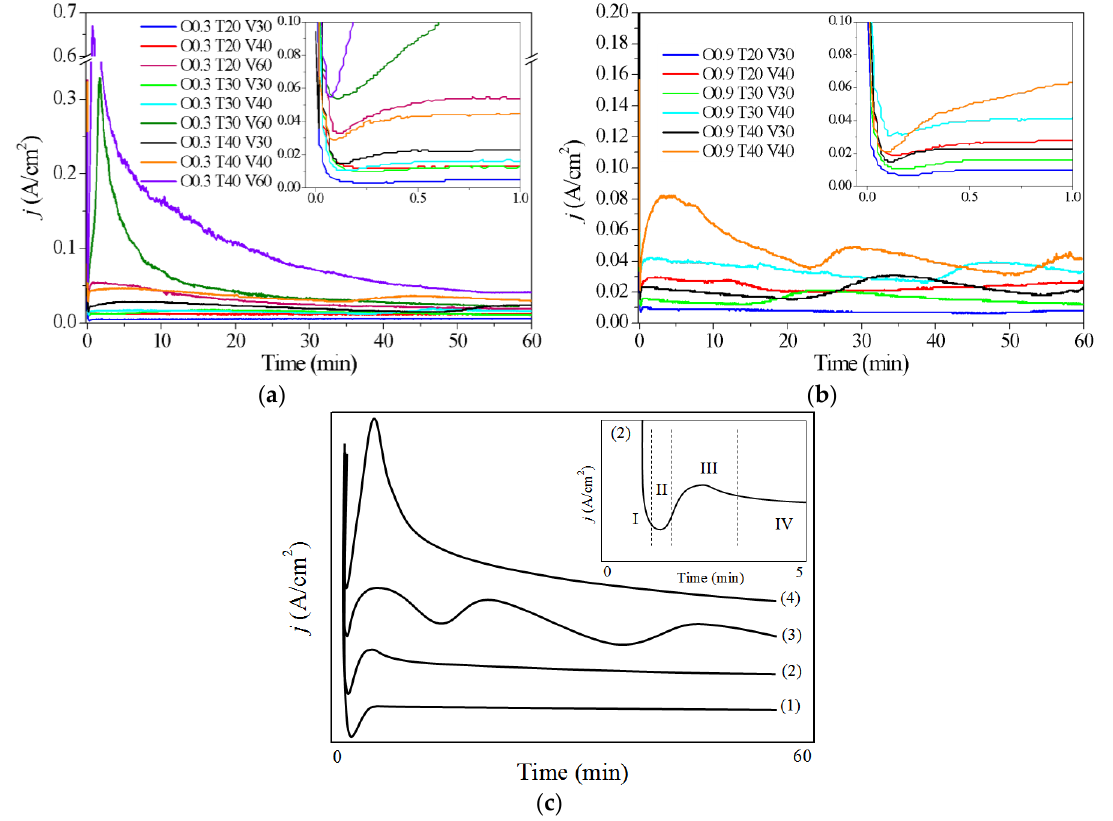
Figure 1. Current density ( j ) vs time recorded during the first anodization step in 0.3 M ( a ) and 0.9 M ( b ) oxalic acid at different voltages and temperatures; insets: first stages of anodization. Current density vs. time curves representative of anodic behavior in different synthesis conditions ( c ); inset: stages of pore growth: I: formation of barrier layer, II: formation of pore precursor pits, III: formation of pores and IV: growth in of pores stationary state (Inset adapted from Sulka [3]).